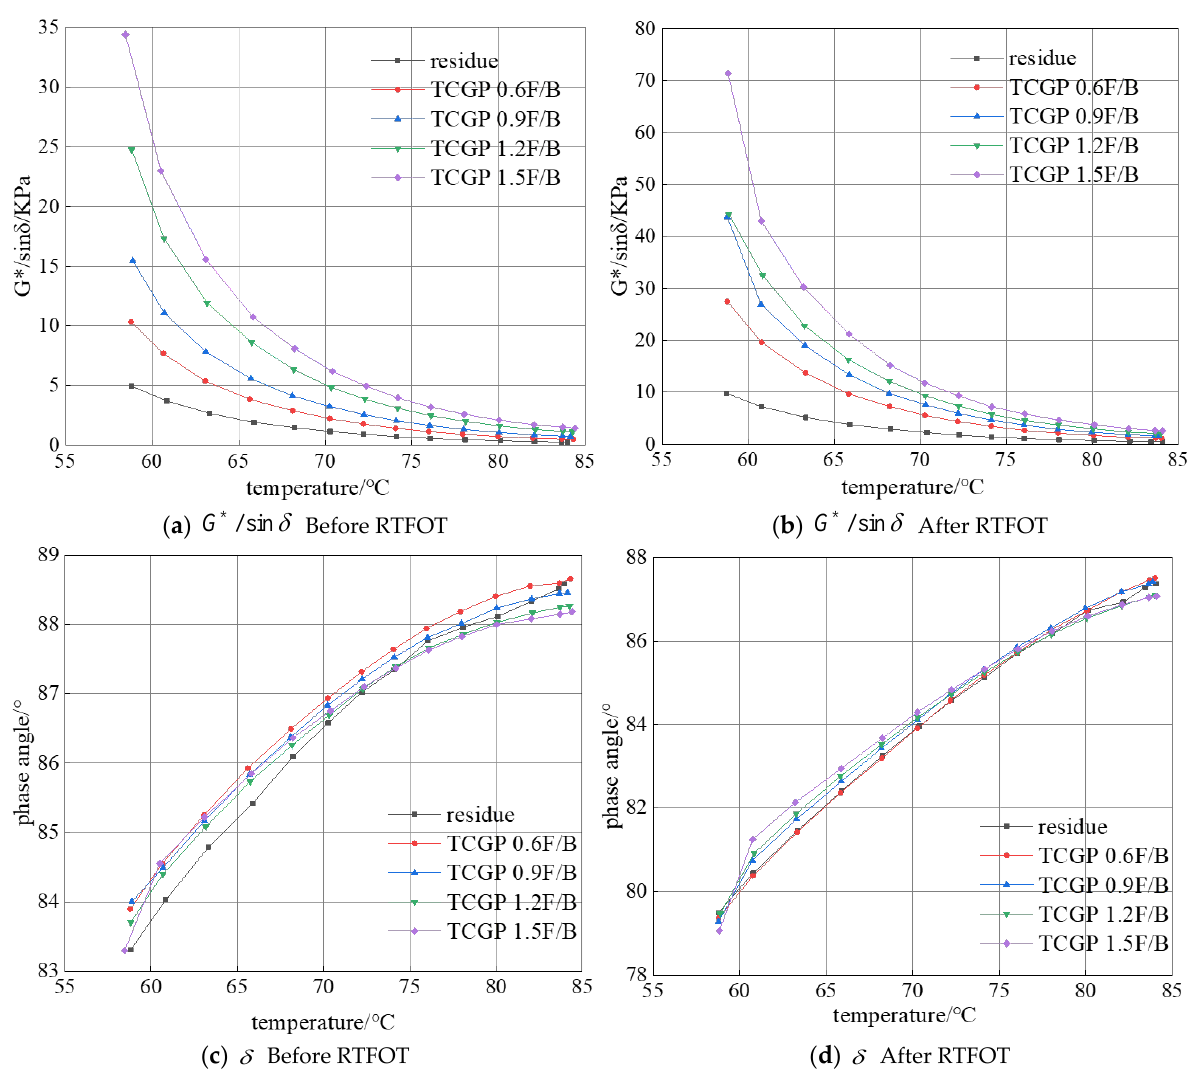
Figure 4. Temperature scanning test results of coal gangue powder asphalt mastics. Note: filler binder ratio (F/B); limestone powder (LP); tunneling coal gangue pow- der (TCGP); portland cement (PC).